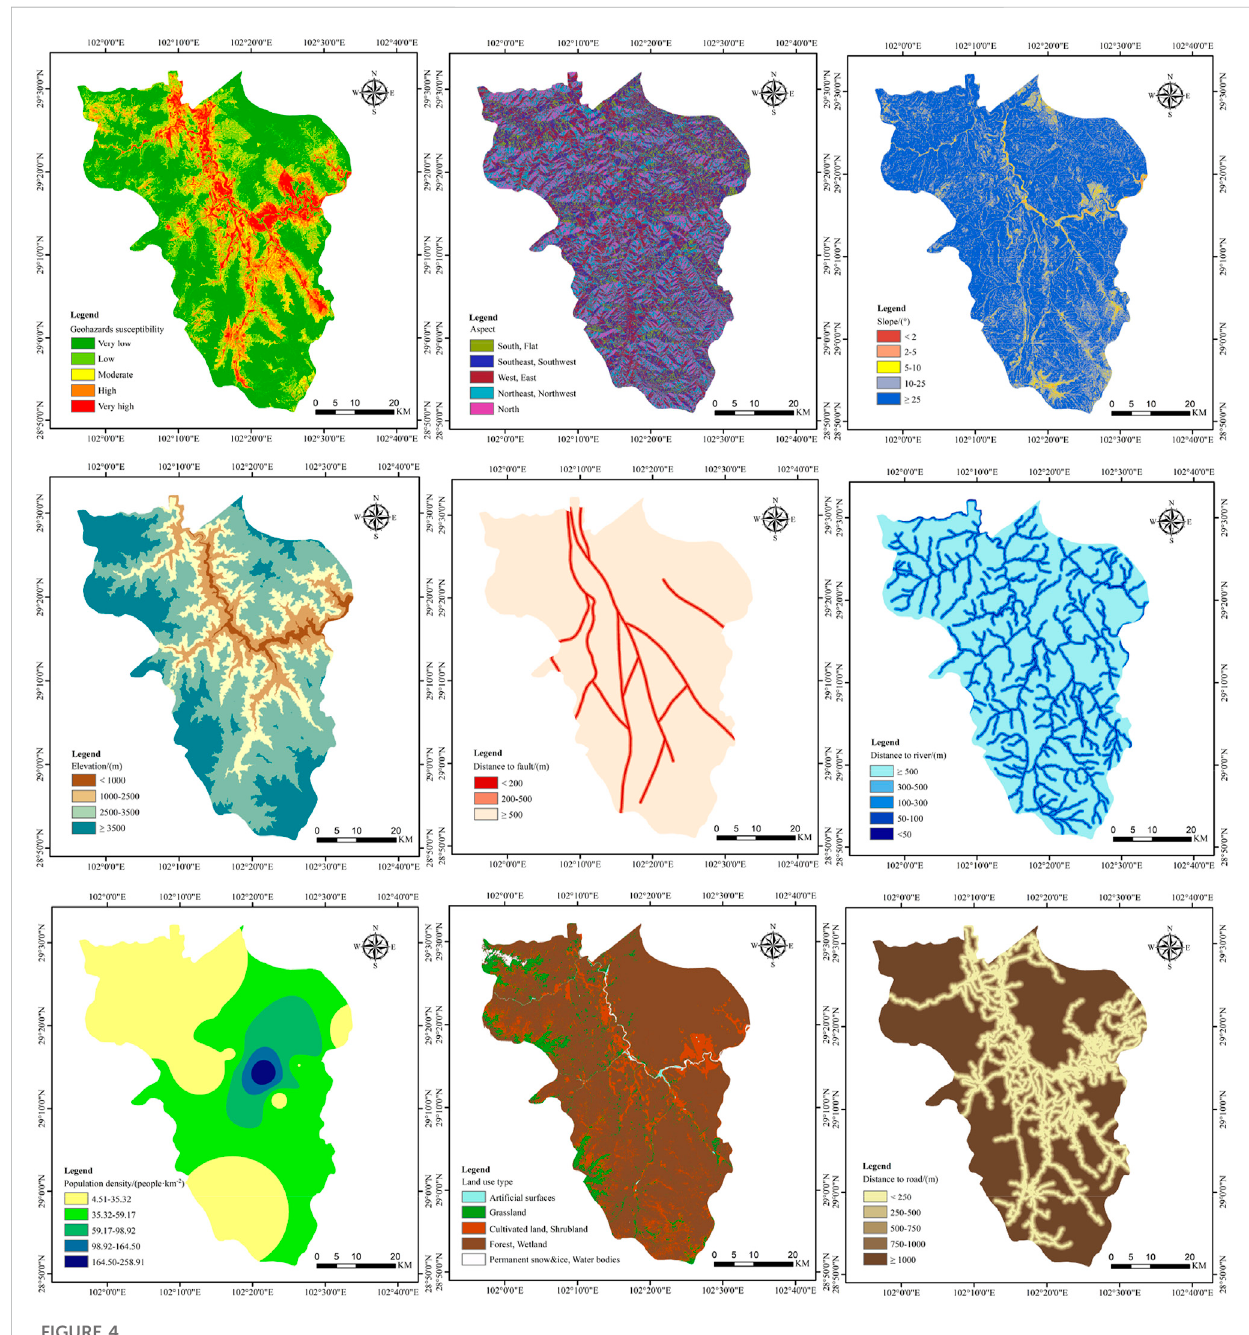
FIGURE 4 Detailed diagram of suitability evaluation index classi fi